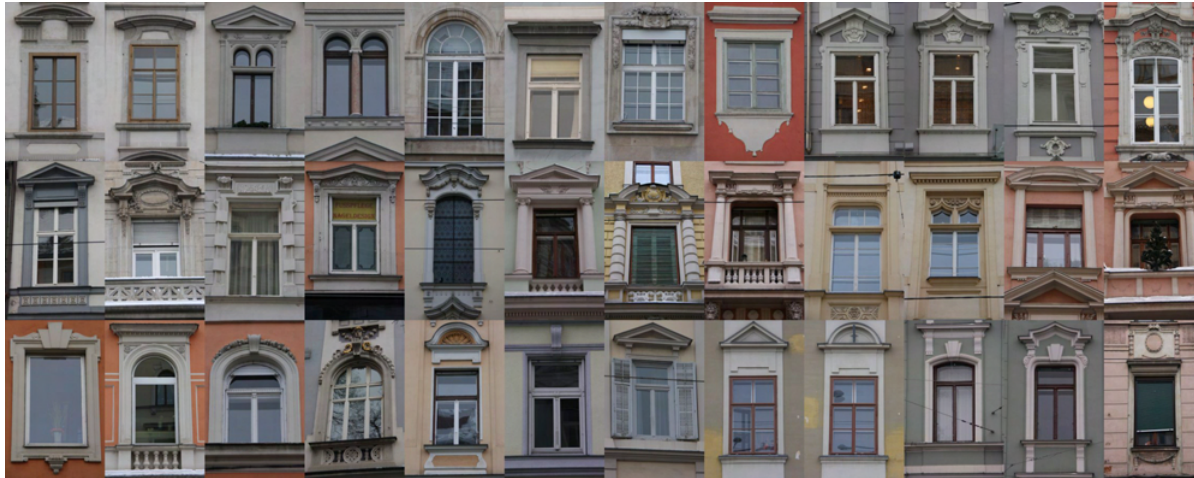
Figure 2: Window exemplars. The full set contains 150 images of windows from neo-classical buildings erected in Graz, Austria, in 1860-1890 ( Gr¨underzeit ). The complexity and visual dominance of the windows pose challenges to any digital urban